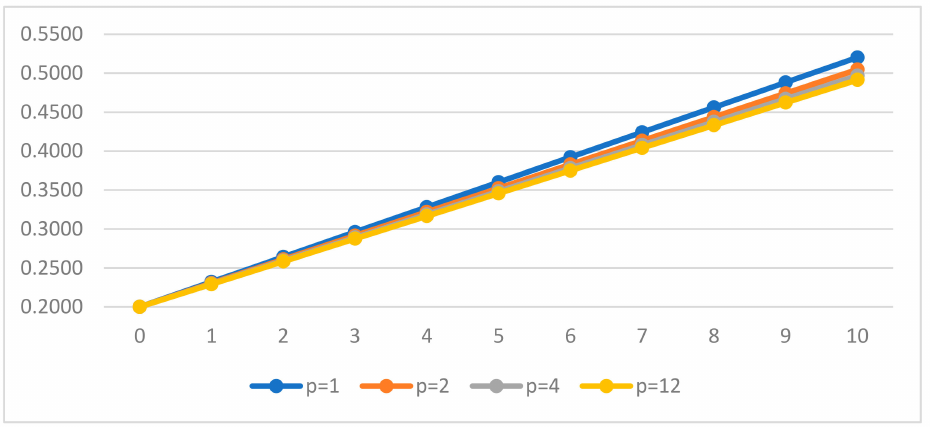
Figure 16. Dependence of the equity cost, k e , on leverage level L at different frequency of payments